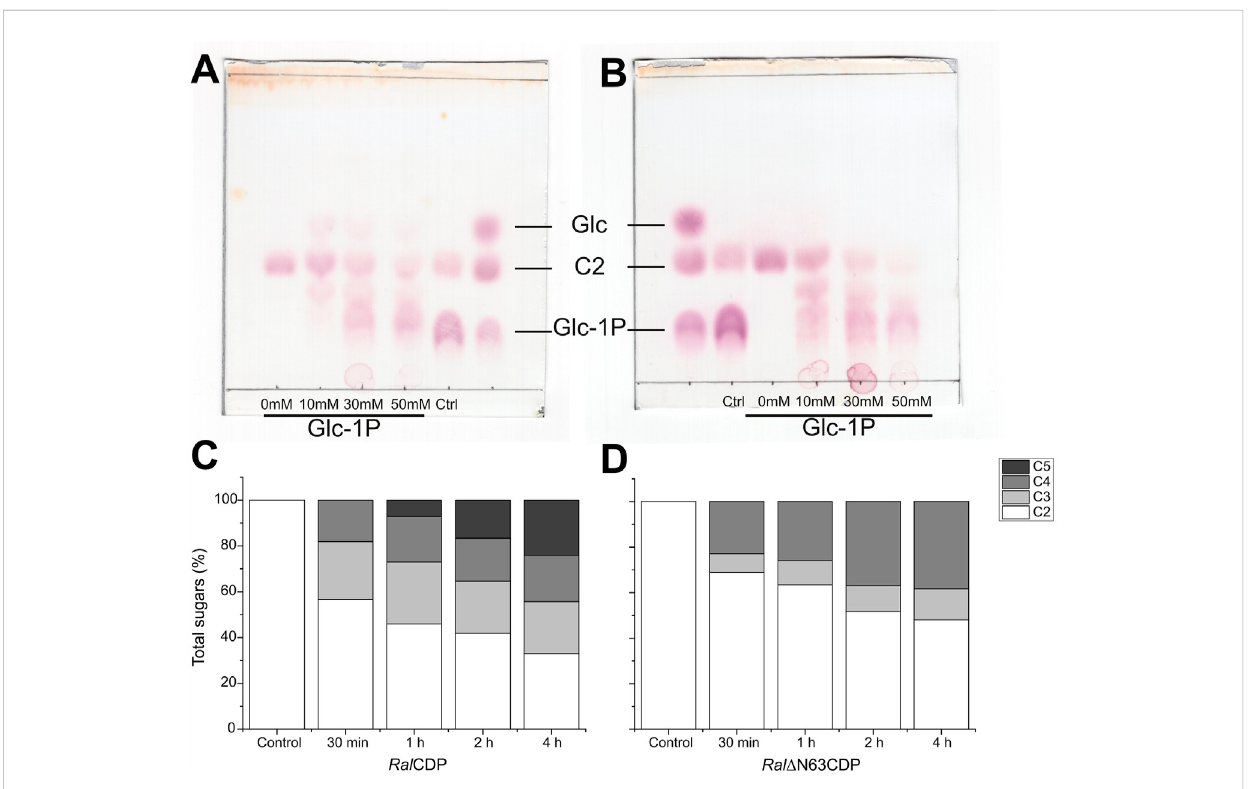
FIGURE 7 TLCanalysisof Ral CDP (A) and Ral Δ N63CDP (B) reactionsatdifferentGlc-1P:cellobioseratios.HPLCanalysisofcello-oligosaccharidessynthesized by Ral CDP (C) and Ral Δ N63CDP (D) .